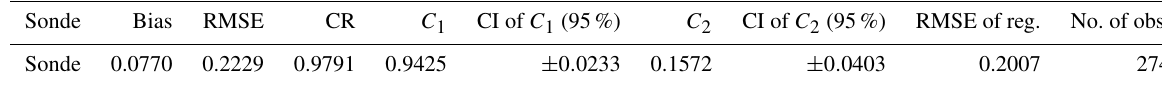
Table 6. Same as Table 4 except for radiosonde and corrected POM-02 precipitable water vapor. POM-02 Bias RMSE CR C 1 CI of C 2 CI of RMSE of reg. No. of obs. C 1 (95%) C 2 (95%) Sun and moon − 0 . 0027 0.0830 0.9946 1.0042 ± 0 . 0173 − 0 . 0077 ± 0 . 0246 0.0829 142 Sun 0.0115 0.0848 0.9945 1.0160 ± 0 . 0206 − 0 . 0061 ± 0 . 0278 0.0831 105 Moon − 0 . 0454 0.0794 0.9966 0.9869 ± 0 . 0271 − 0 . 0272 ± 0 . 0434 0.0643 37